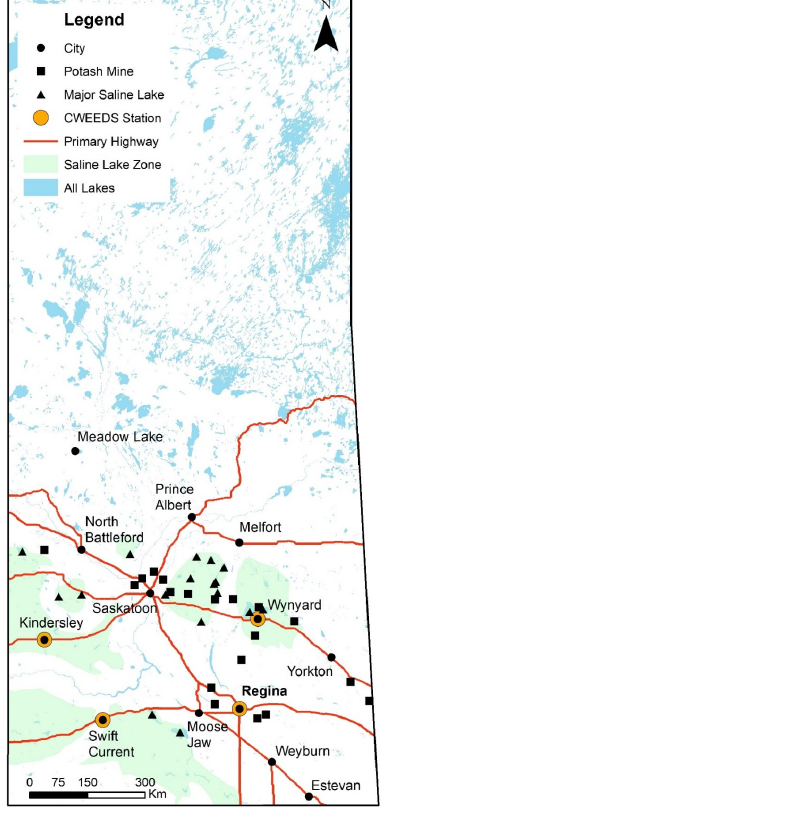
Figure 1. Geographical distribution of freshwater lakes, saline lakes, and potash mines in Saskatchewan, Canada.